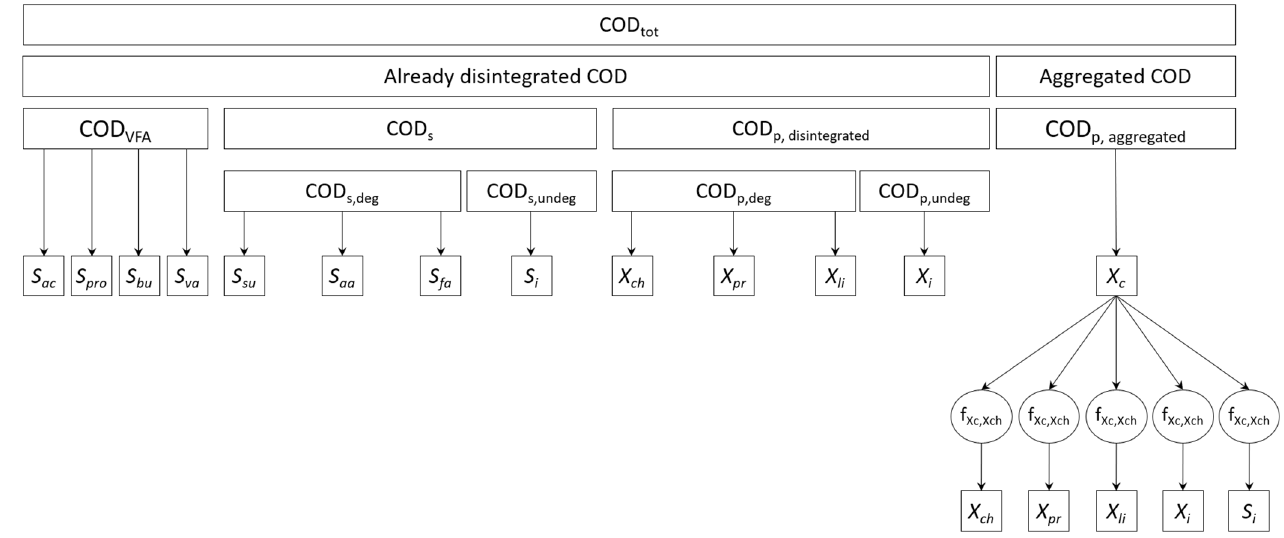
Figure 1. Scheme of substrates fractionation used to determine input state variables.